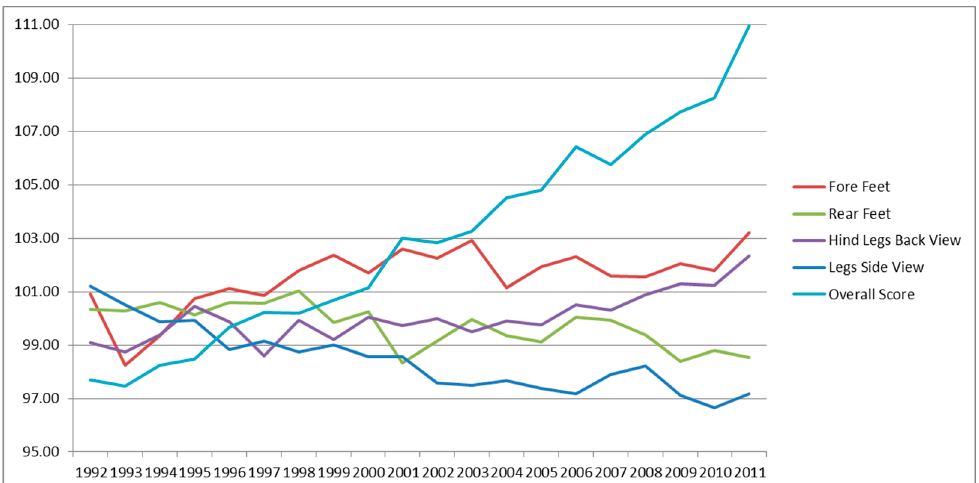
Figure 3. Genetic trends for legs traits and overall score.